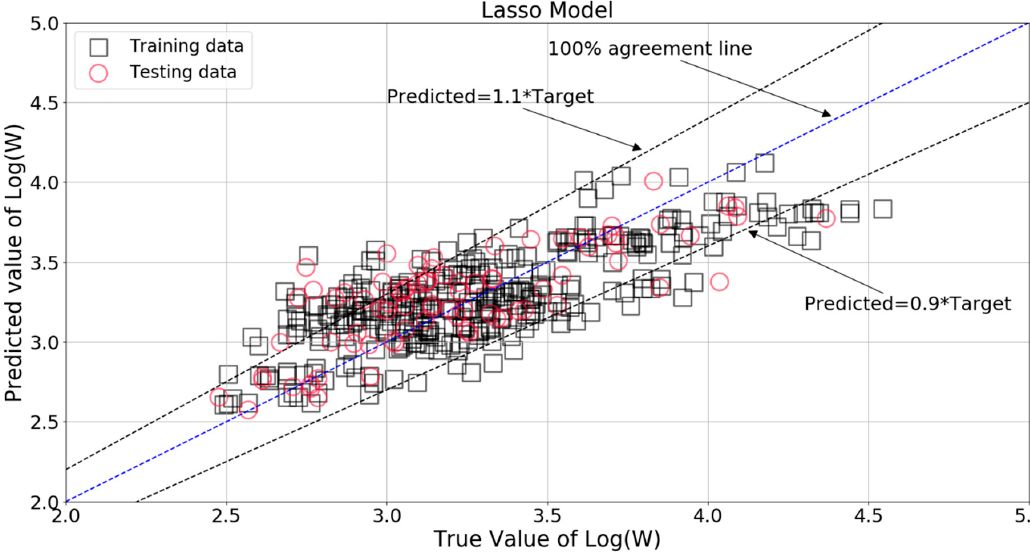
Figure 14. Comparison between the target and Lasso model predicted Log(W).